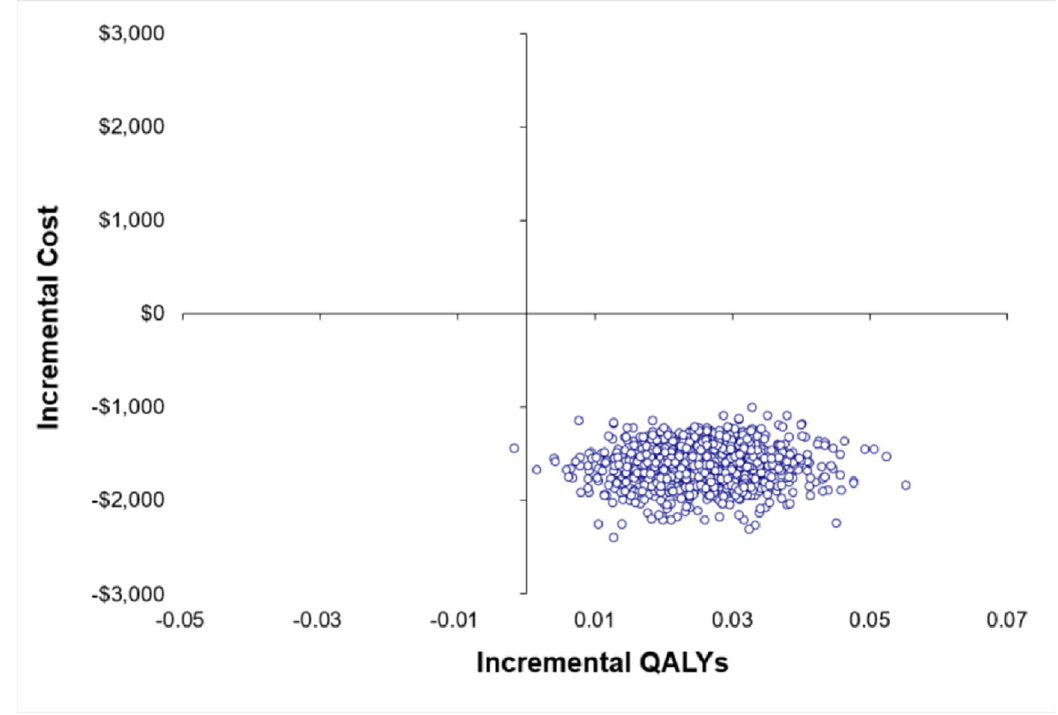
Fig 3. Incremental cost-effect pairs from 1000 bootstrap resamples for QALY change.